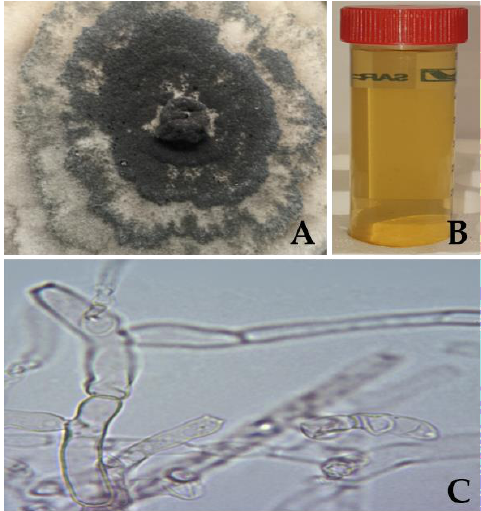
Figure 1. C. thermophilum biological characterisation. ( A ) Fungal growth in CTMA medium. ( B ) Fun- gal cell-free extract ready to be used in nanoparticles synthesis. ( C ) Microscope image of mycelia cells with 100 ×